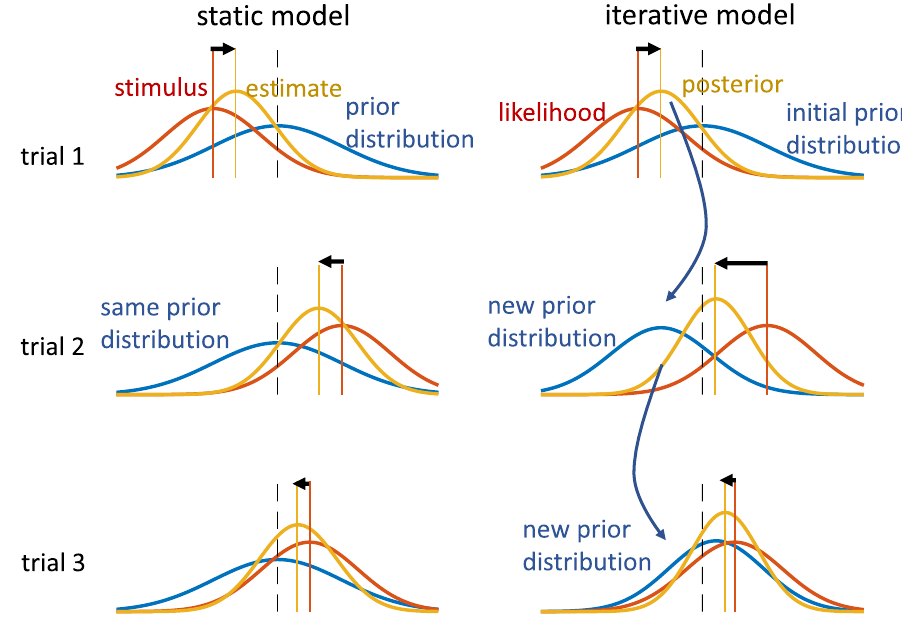
Figure 1. Two Bayesian estimation models (static and iterative) for magnitude perception. The static model uses static time-independent prior knowledge (blue prior distribution), while the iterative model dynamically updates the prior knowledge on each trial. In trial 1 (upper row), in both cases the prior knowledge (blue) and the stimulus (orange line), to which a likelihood distribution (orange) is attached, are the same for both models. Thus, the estimate, shown as posterior distribution (yellow) and computed by multiplying prior and likelihood, is also equal for both cases, already showing the characteristic overestimation of small amplitudes. The black dashed line serves as visual reference and is aligned with the mean of the initial prior. In trial 2 (middle row), the stimulus and likelihood are again the same for both models, but the prior differs: the static model takes